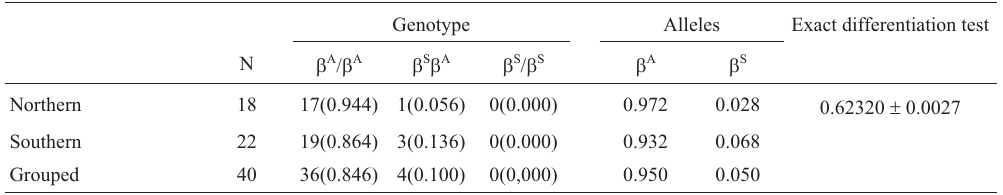
Table2 -Genotypeandallelefrequenciesofthe (cid:3) S mutationandresultsofthedifferentiationtestbetweentheNorthernandSouthernsub-populations. Genotype Alleles Exact differentiation